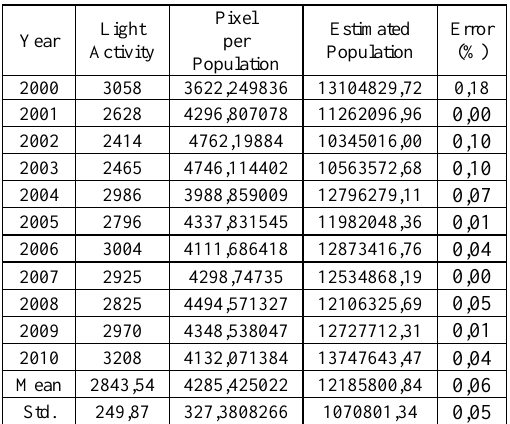
Table 3. Estimated results for İstanbul population between 2000 and 2010 Real population for İstanbul is estimated between 2011 and 2013 in Table 4.